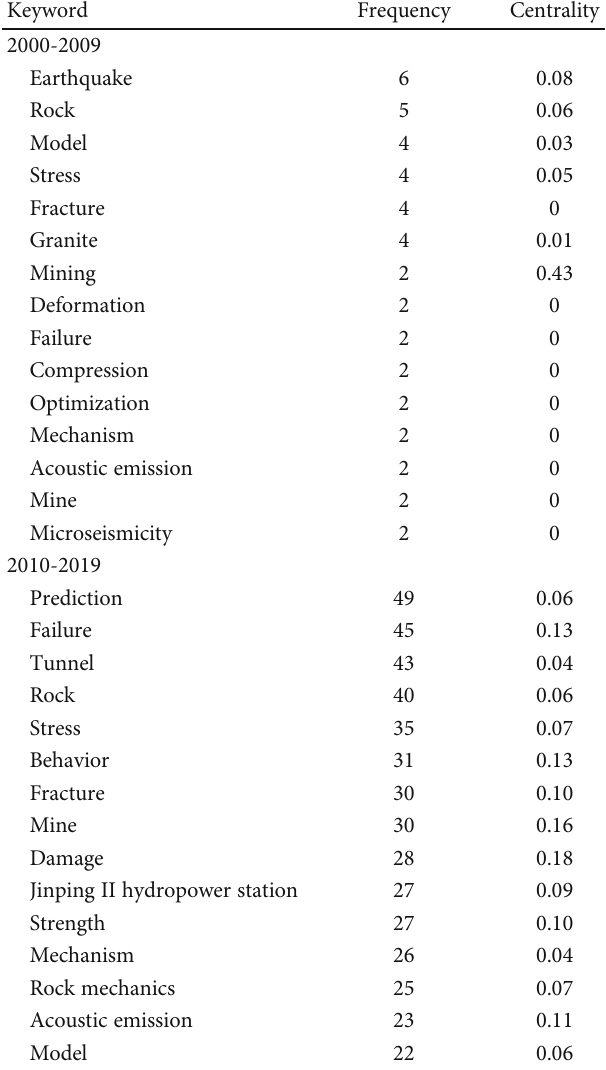
Table 1: Top 15 keywords related to rockburst in hard rock during 2000-2009 and